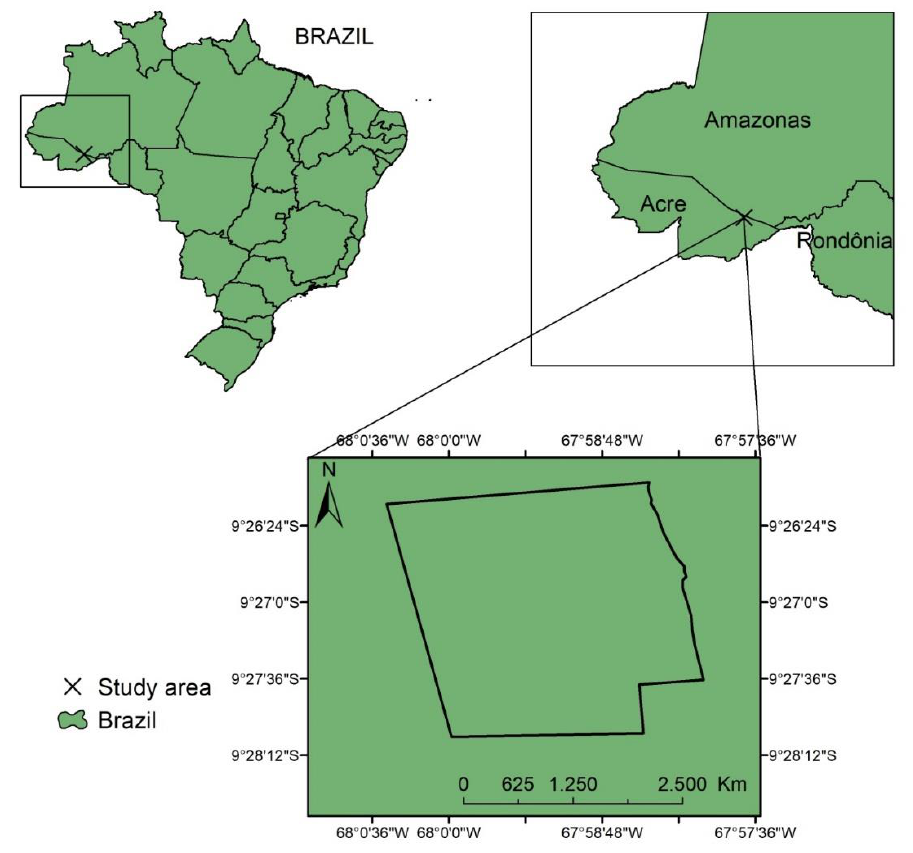
Figure 1. Location of the study area in the southwestern Amazon, in the municipality of Porto Acre, Acre, Brazil.